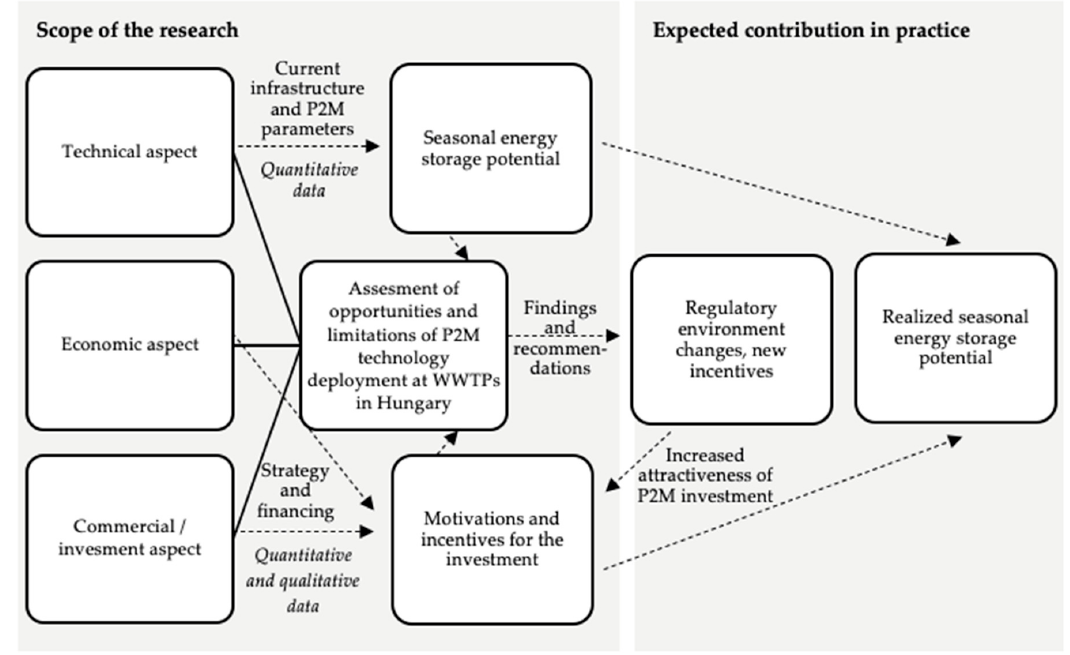
Figure 1. Research framework. The scope of the research incorporates the assessment of opportunities and limitations of P2M technology deployment at WWTPs in Hungary in terms of technical, economic,